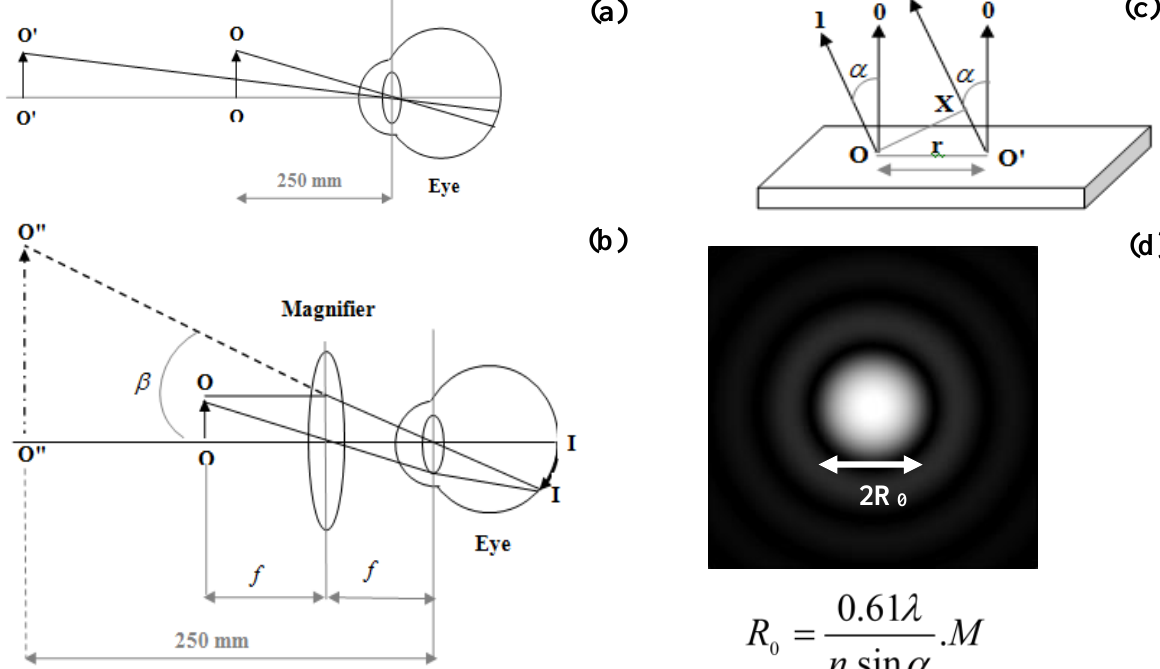
Figure 1. ( a ) Image formation at the eye from a distant object O’-O’ and the one O-O at the nearest distance of distinct vision; ( b ) ray diagram showing the principle of a simple magnifier for increasing the viewing angle of the object O-O and the image of the object on the retina (I-I) formed from the Figure 1. (a) Image formation at the eye from a distant object O'-O' and the one O-O at the nearest 116 virtual image O”-O” at the nearest distance; ( c ) ray diagram of the zero-order direct light (0) and the distance of distinct vision; (b) ray diagram showing the principle of a simple magnifier for increas- 117 1st-order reflected light (1) from two points separated by r ; ( d ) the relationship between the radius of the airy spot and the magnification ( M ) by a lens for a point light ing the viewing angle of the object O-O, the image of the object on the retina (I-I) formed from the 118 virtual image O"-O" at the nearest distance; (c) ray diagram of the zero-order direct light (0) and the 119 1 st -order reflected light (1) from two points separated by r ; (d) the relationship between the radius